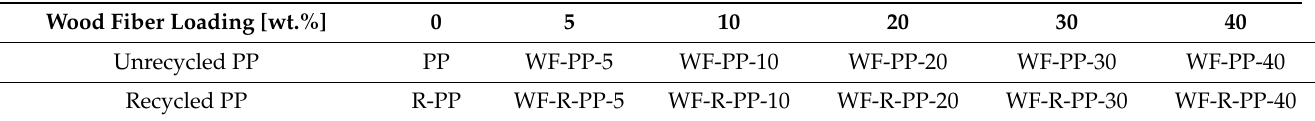
Table 1. Prepared materials composites and names of individual